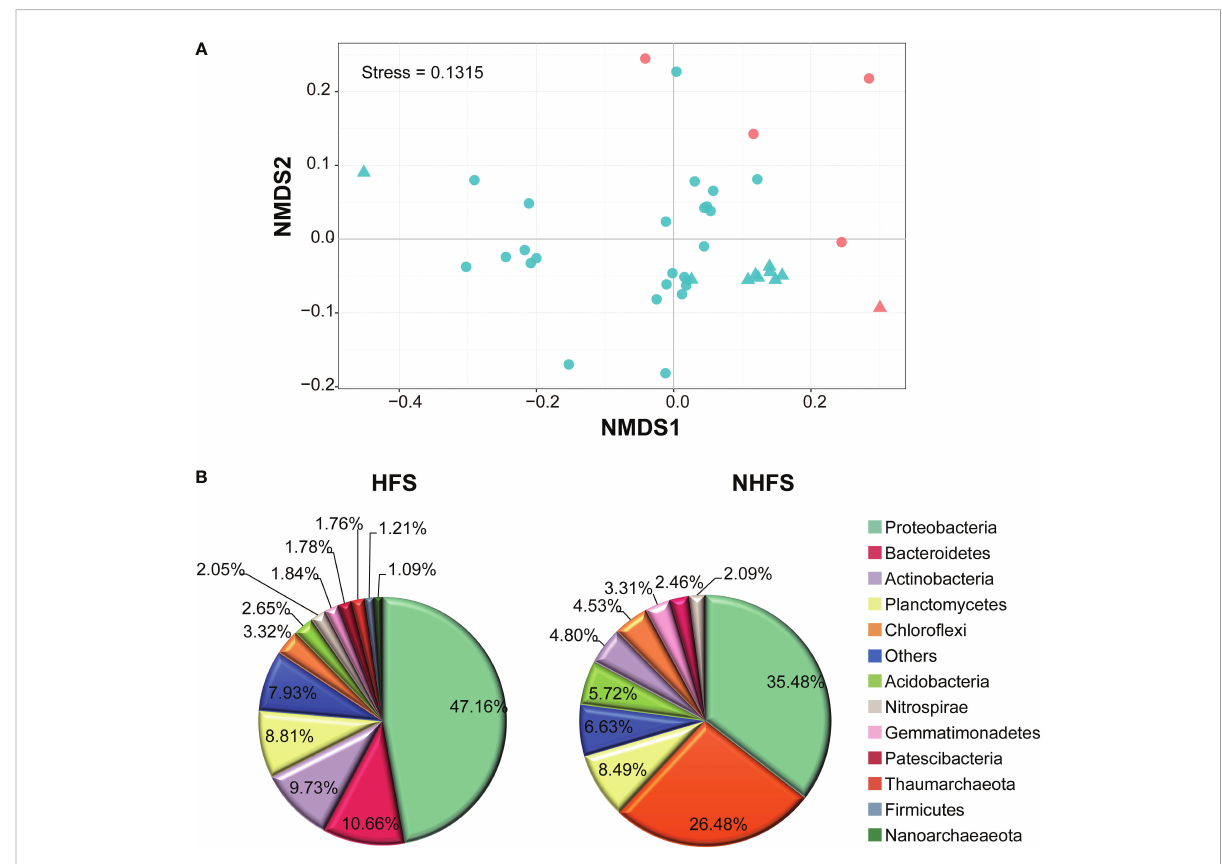
FIGURE 3 Differences between the HFS and NHFS samples in prokaryotic community structure. (A) NMDS of all 39 subsamples based on Bray-Curtis dissimilarities of 16S rRNA gene, representing the dissimilarity of the prokaryotic community composition in the samples at 97% OTU similarity. The red and blue colors indicate HFS and NHFS samples, respectively; the dots and triangles indicate CR and SWIR samples, respectively. (B) Pie graphs showing the dominant phyla (relative abundance >1%) in the HFS and NHFS